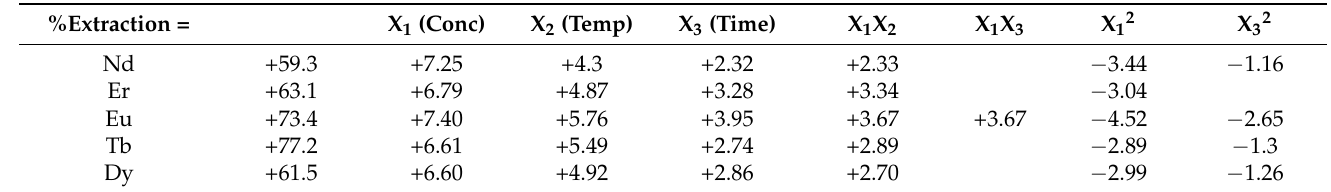
Table 11. Final % Extraction Equation in terms of coded factors (eliminating insignificant terms; p -value > 0.05).